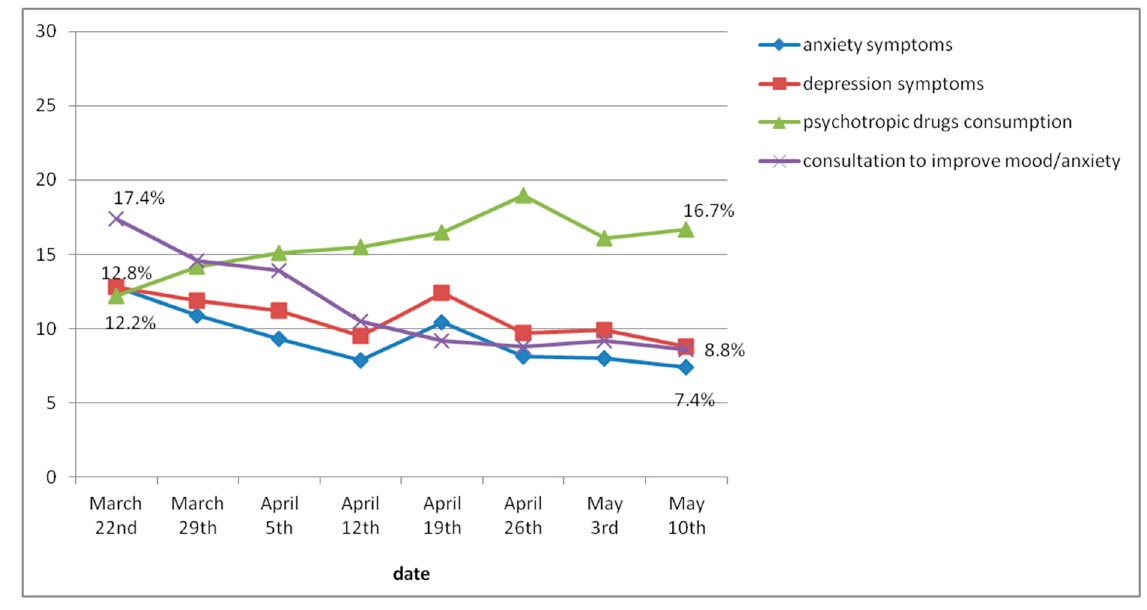
Figure 1. Global evolution of psychological well-being indicators.